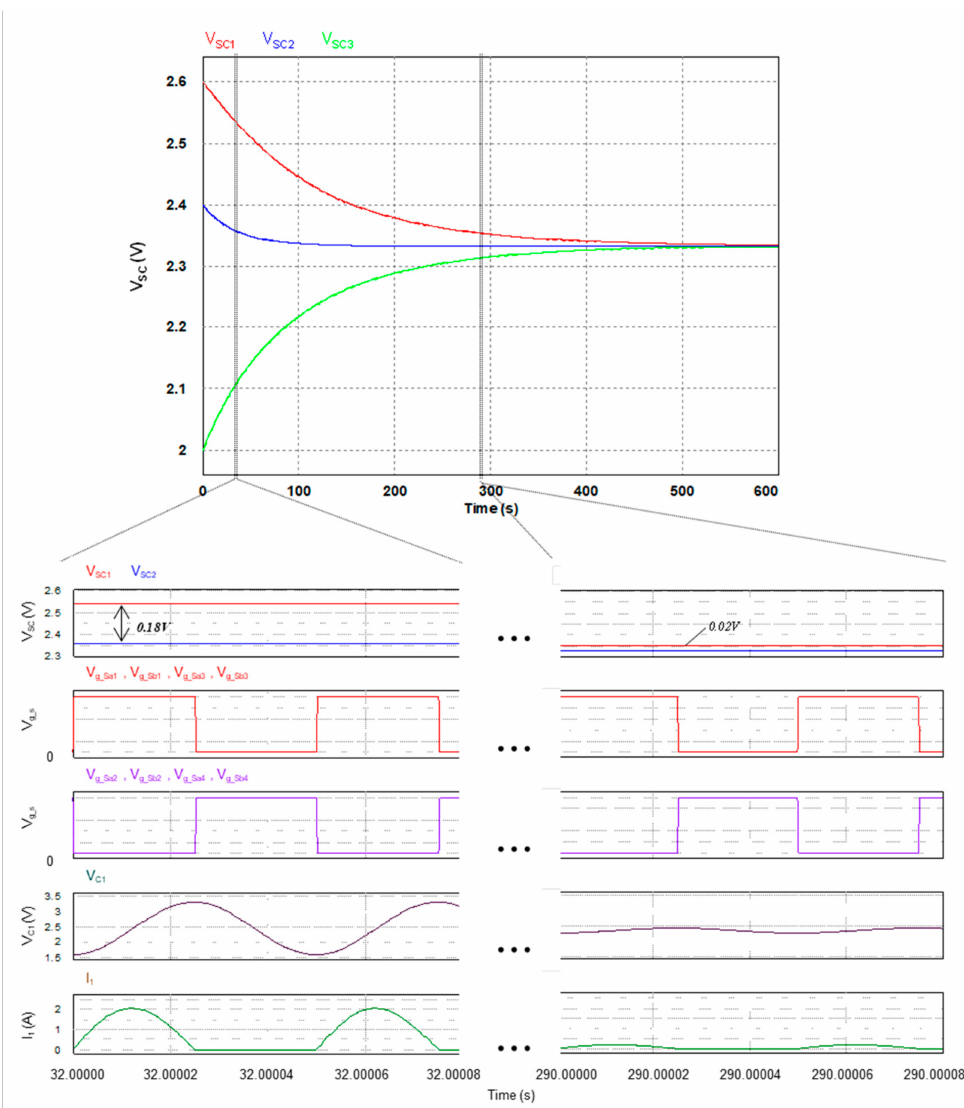
Figure 9. Simulation results of ZCS mode under 20 kHz frequency with 350 F